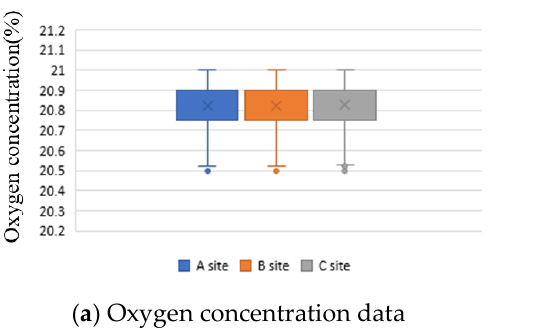
Figure 12. Analysis of hazardous gas detector data for test beds.